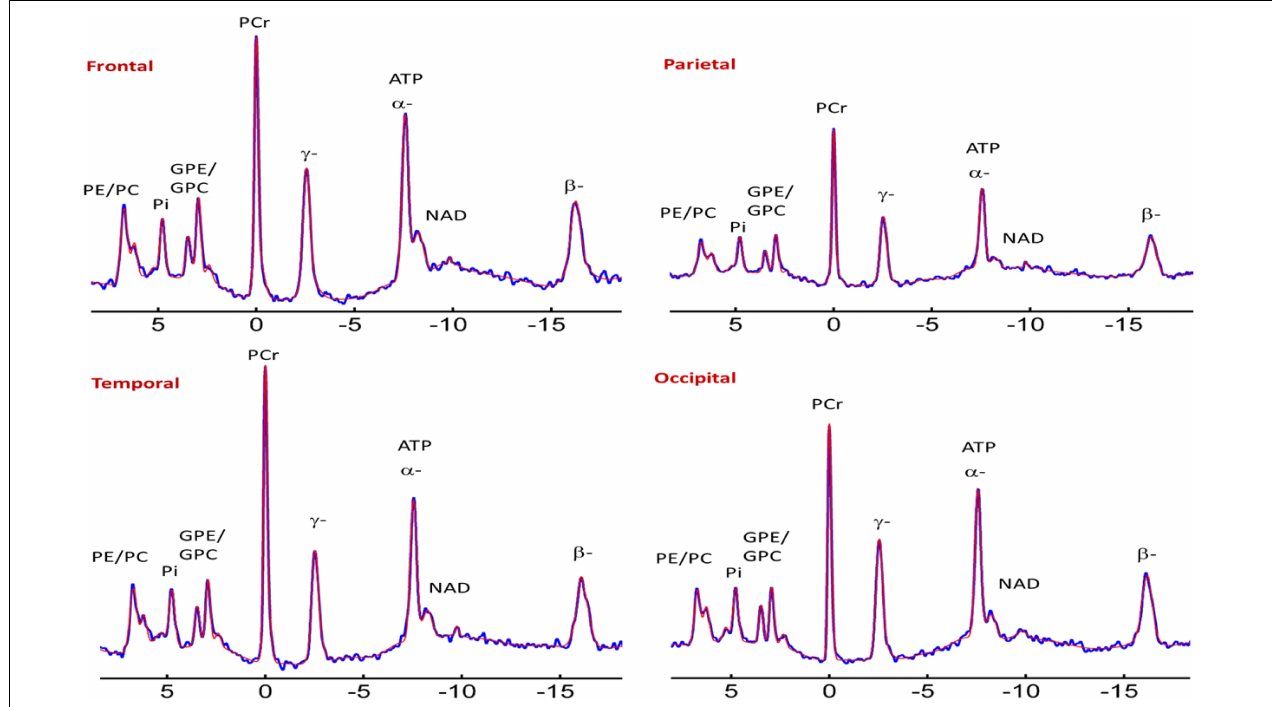
FIGURE 2 | Representative spectra from the frontal, parietal, temporal, and occipital brain areas of a cognitively normal adult. Zero filling to 8,000 data points with 8 Hz vogit lineshape model applied for the display purpose. PE, phosphoethanolamine; PC, phosphocholine; Pi in , inorganic phosphate internal, respectively; GPE, glycerophosphoethanolamine; GPC, glycerophosphocholine; PCr, phosphocreatine; ATP forms: α , β , and δ adenosine triphosphate; NAD, nicotinamide adenine dinucleotide; UDPG, uridine diphosphate glucose.